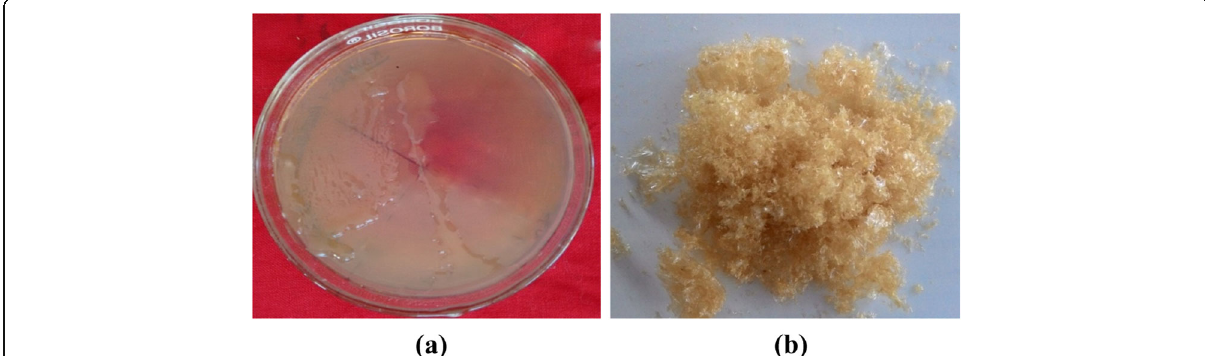
Fig. 2 a EPS production. b The polysaccharide fractions obtained were then pooled, concentrated and lyophilized for further